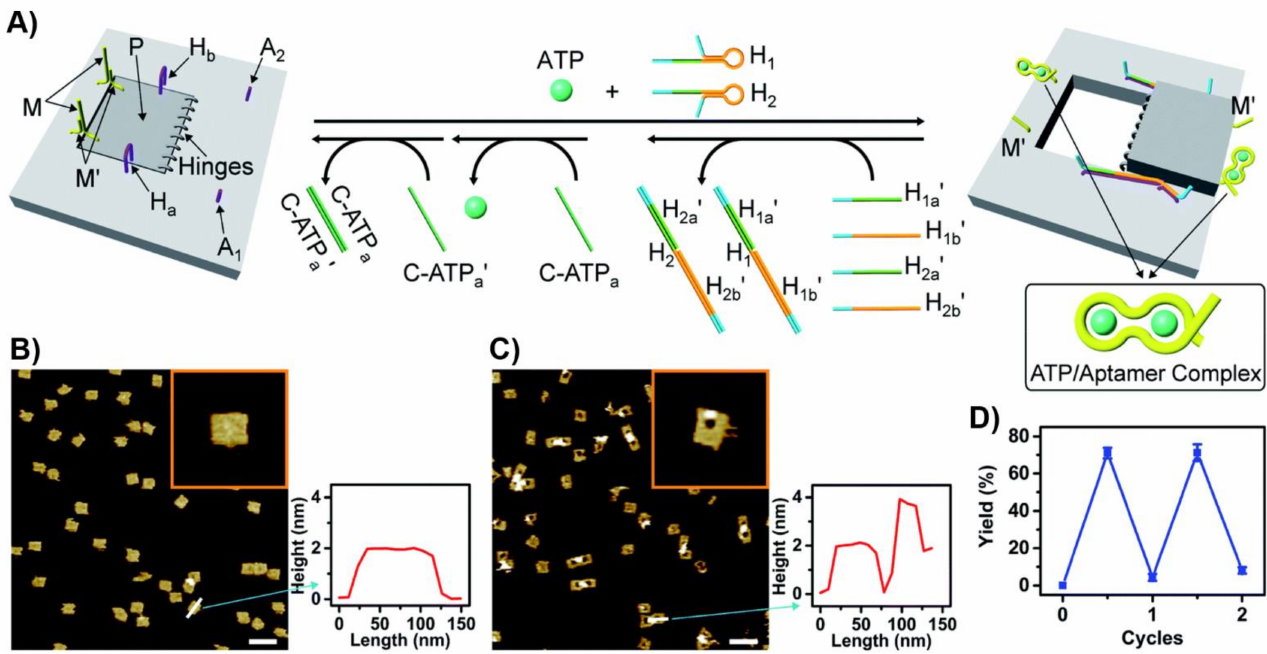
Figure 18. ( A ) Schematic “mechanical” open of a “window patch” in an origami tile using the formation of ATP/APT aptamer complexes as a mechanism to unlock the “window”. The formation of the ATP/ATP aptamer complexes followed by the binding of helper strands to “window” handles and their stretching to bind the stature foothold, associated with the origami scaffold led to the fixed rigid opening of the “window” and to the formation of a nanocavity in the origami raft. The reverse unlocking of the foothold binding strand and the release of ATP relocks the caped “window” structure. ( B ) AFM images of the locked origami structures and accompanying cross-section analysis. ( C ) AFM image of the cavity containing unlocked origami rafts and accompanying cross-section analysis. ( D ) Switchable and reversible ATP-driven opening and closure of nanocavities in the origami raft. Reproduced with permission from ref. [217]. Copyright 2020 Royal Society of